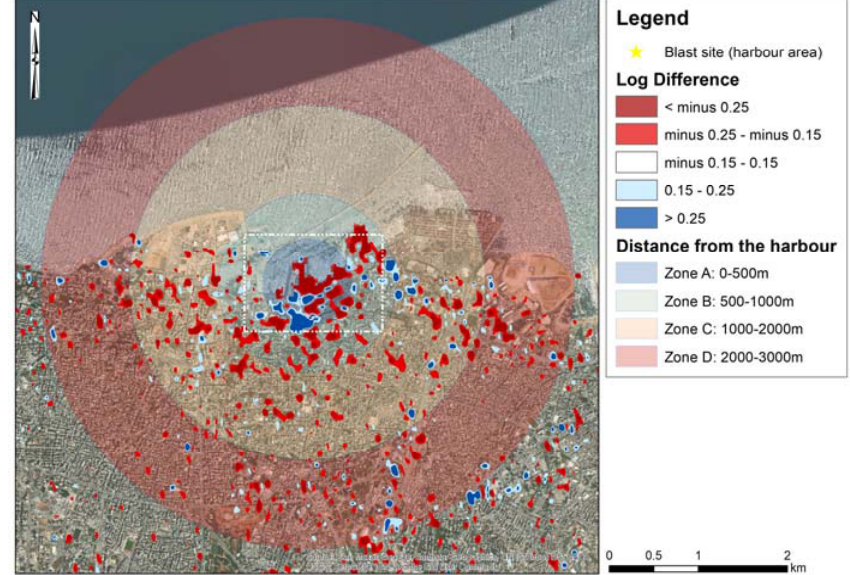
Figure 3. Change detection results using the log di ff erence of the VV and the VH backscattering amplitude. Significant changes of the pair of images are presented with dark red and blue colors ( > − 0.25 or > 0.25 di ff erences), while other minor changes in the range of − 0.25 to − 0.15 and 0.15 to 0.25 are also presented in light red and blue colors, respectively. The four zones under study (Zone A to Zone D) are also given. The location of the blast size is shown with the yellow star at the center of the figure. The white dashed rectangle around the blast site is indicating the zoom area presented in Figure 4.